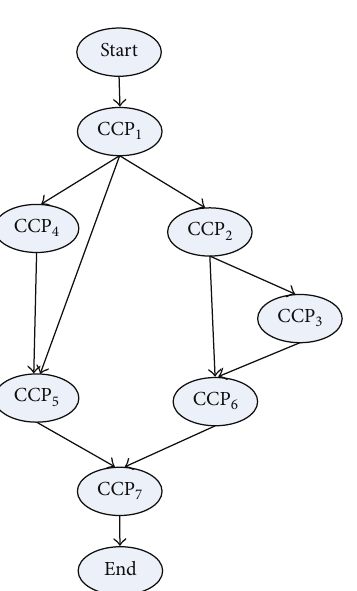
Figure 3: CCPDAG corresponding to the DAG as shown in Figure 1 and the CCP as indicated in Table 1.